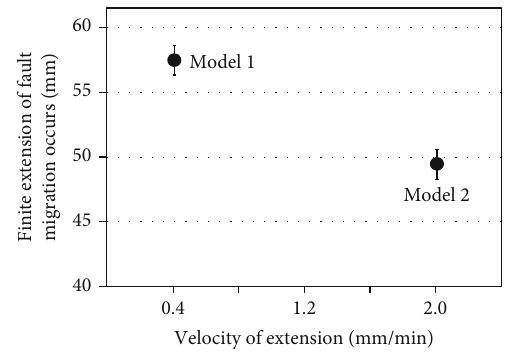
Figure 5: Summary of series 2 experiments (variable extension rate) illustrated as plots of the bulk extension corresponding to the fi rst appearance of internal faults as a function of extension rate.